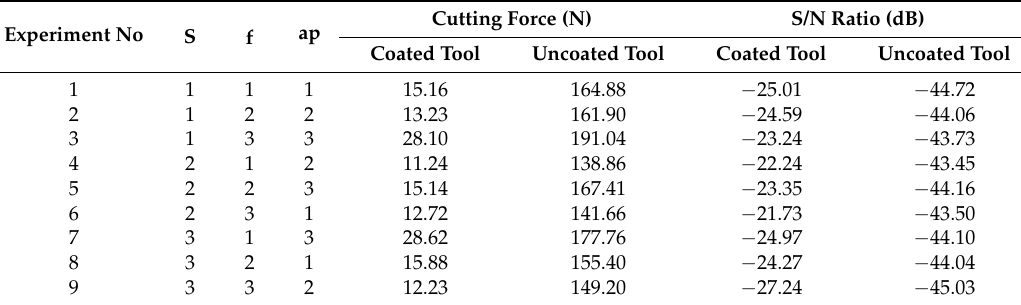
Table 5. The experimental results for cutting force and S/N ratio.